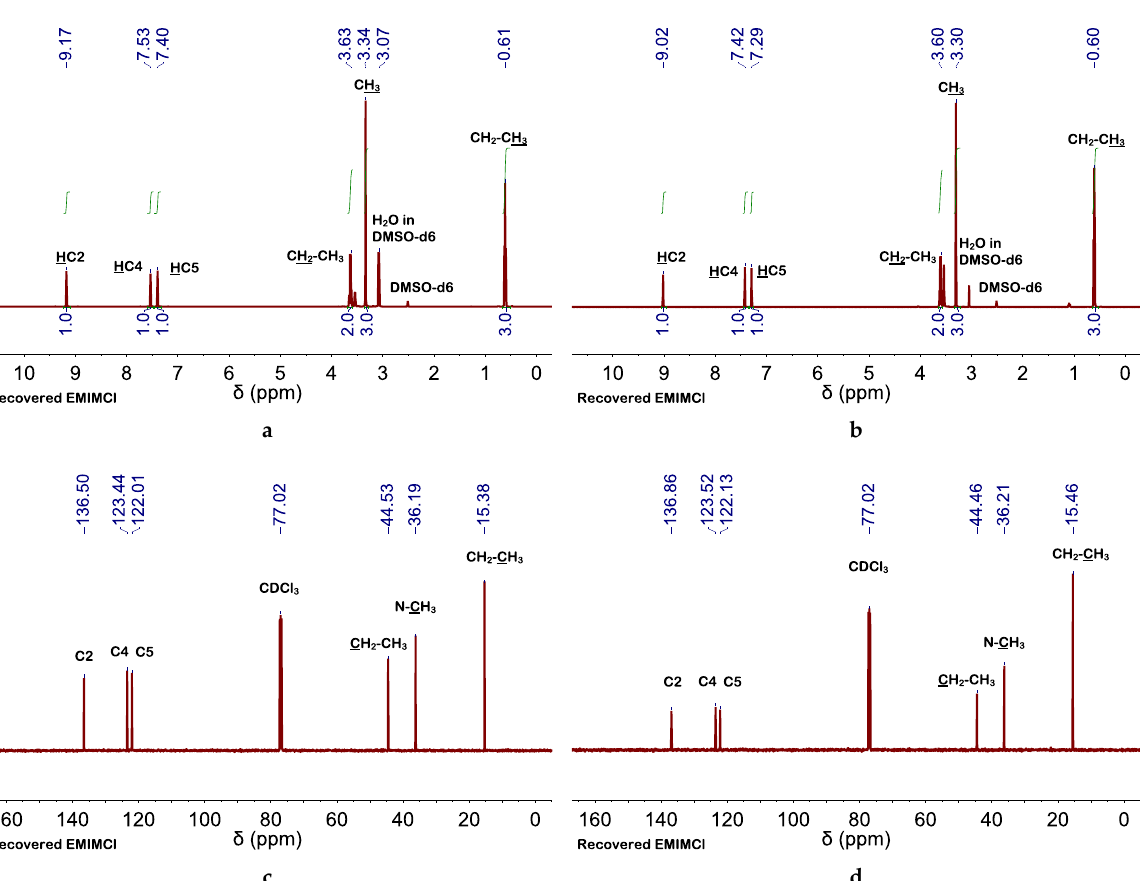
Figure 2. ( a , b ) 1 H and ( c , d ) 13 C NMR spectra of recovered EMIMCl ( a , c ) using H 2 O as the antisolvent or ( b , d ) adding first AcOH and promoting the transition from EMIMCl- to EMIMCl · HOAc-based mixtures. 1 H and 13 C NMR spectra were performed at 85 and 25 ◦ C,